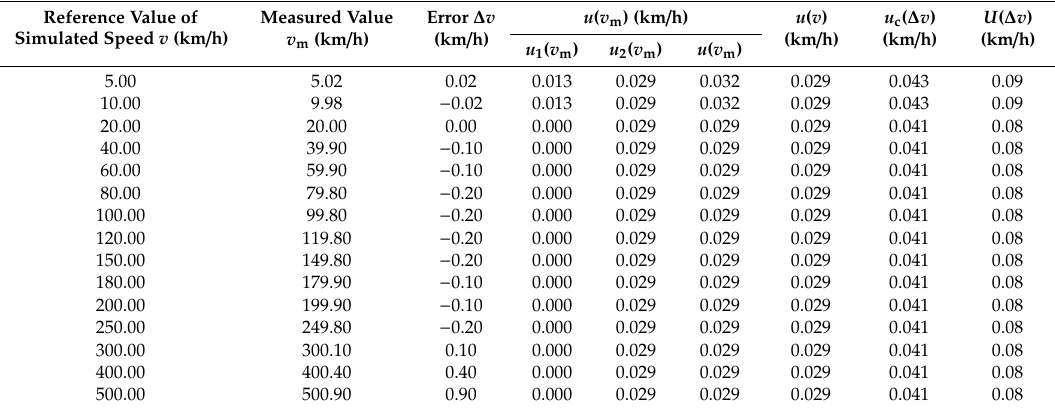
Table 12. Uncertainty evaluation results of the DRS05 / 1a sample.